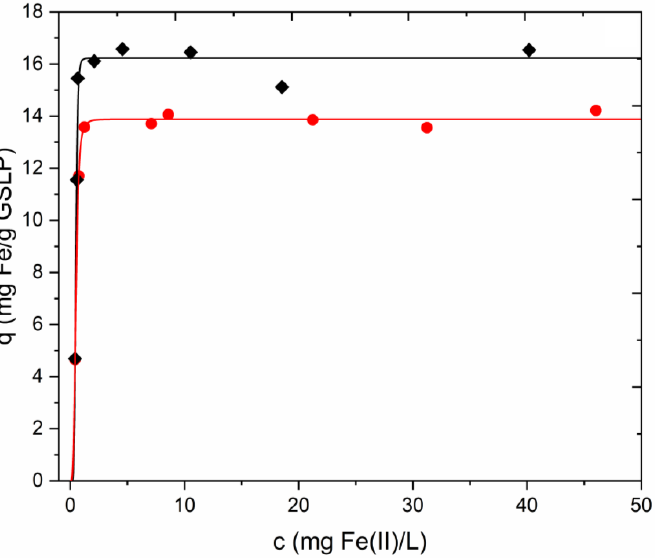
Figure 8. Experimental data for Fe(II) sorption on GSLP D3 ( ● ) and GSLP D2 ( ♦ ). Solid lines were obtained by fitting with Equation (8). GSLP dose of 2 g·L − 1 , natural pH (ca. 5), room temperature, and stirring at 200 RPM. Initial Fe(II) concentration from 10 to 75 mg·L − 1 was used. The amount of Fe adsorbed on GSLP was confirmed by desorption. A 0.25 M HCl solution was used because it caused complete stripping of the iron present in the pellets but did not alter its oxidation state. An aliquot was also taken from the stripping solution and treated with a reduction procedure to transform any Fe(III) to Fe(II) before measuring the iron in solution. Values of 13.6 ± 0.7 mg Fe·g − 1 GSLP for D3 pellets and 16.0 ± 0.1 mg Fe·g − 1 GSLP for D2 pellets were found, which were consistent with the Q 0 values obtained with Equations (7) and (8) (Table 3). Table 3. Parameters obtained from the isotherm models for Fe(II) sorption, Cr(VI) sorption, and total chromium sorption. The Q 0 value for Cr(VI) removal was obtained directly from the experi- mental data without using any isotherm model. Equilibrium